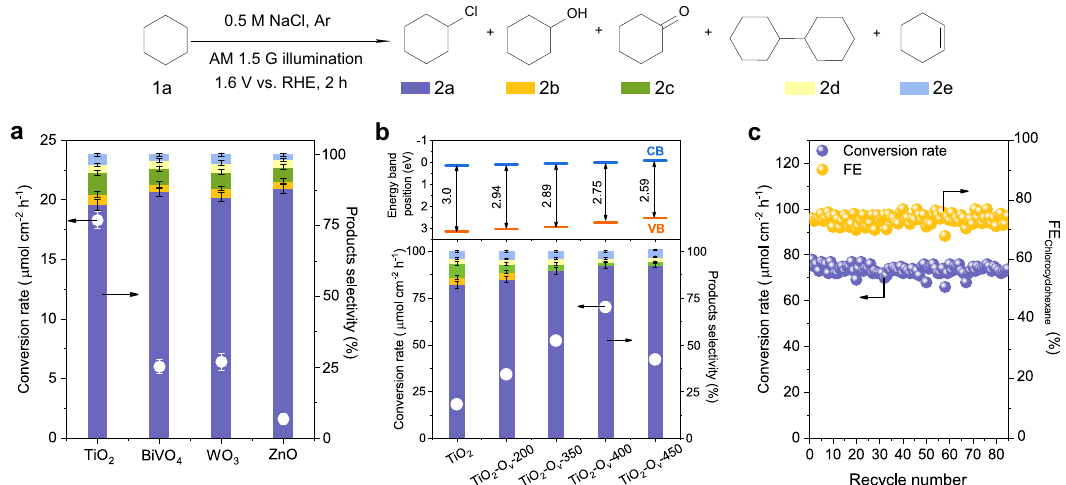
Fig. 3 Cyclohexane chlorination performance via PEC. a Photoelectrocatalytic conversion rate of cyclohexane and corresponding products selectivity over typical semiconductors. b Photoelectrocatalytic conversion rate of cyclohexane and corresponding products selectivity over TiO 2 -O v - T ( T represents the temperatures, 200, 350, 400, and 450 °C) photoanodes. c Stability test of TiO 2 -O v -400 photoanode for the chlorination of cyclohexane for 255 h in batch reaction (85 batches). The reaction was carried out in a batch reaction in 0.5 M NaCl with 18.8 mmol cyclohexane at 1.6 V vs. RHE under AM 1.5G, 100 mWcm − 2 illumination, with 3 h for one batch. The spent TiO 2 -O v -400 photoanode was washed by deionized water and dried under vacuum for the next batch reaction. The error bars represent the relative deviation, which is within 5%. The curves in each fi gure are guides to the